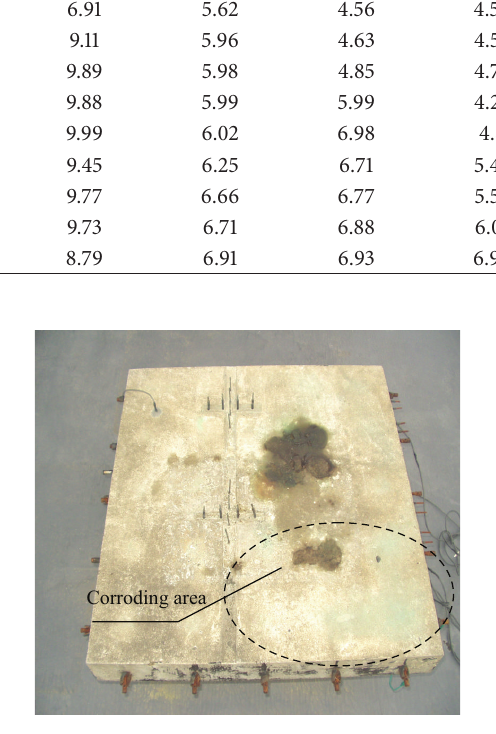
Figure 3: General view of concrete slab